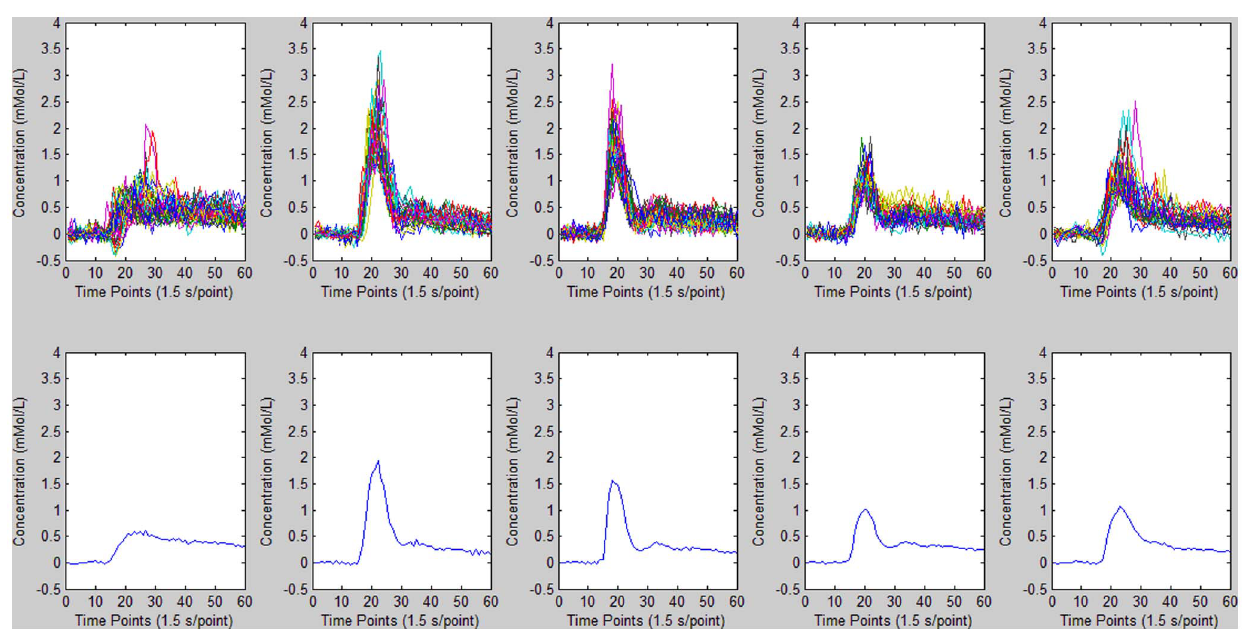
Figure 5. AIF detection results for FCM cluster analysis. Top: time–concentration curves for different clusters. Bottom: mean curves for M values of 5.7745e-004, 0.0145, 0.0135, 0.0070, and 0.0047, respectively. The mean curve for M =0.0145 was thus selected to represent the estimated AIF.